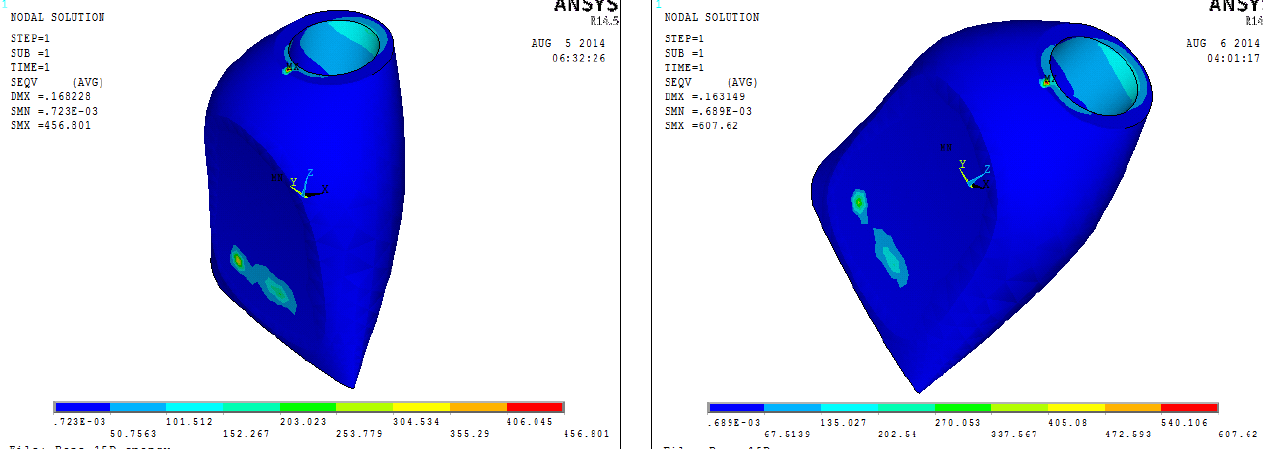
Von Mises stress of indicated expected crown failure as two similar parts with using vertical cutting plane.